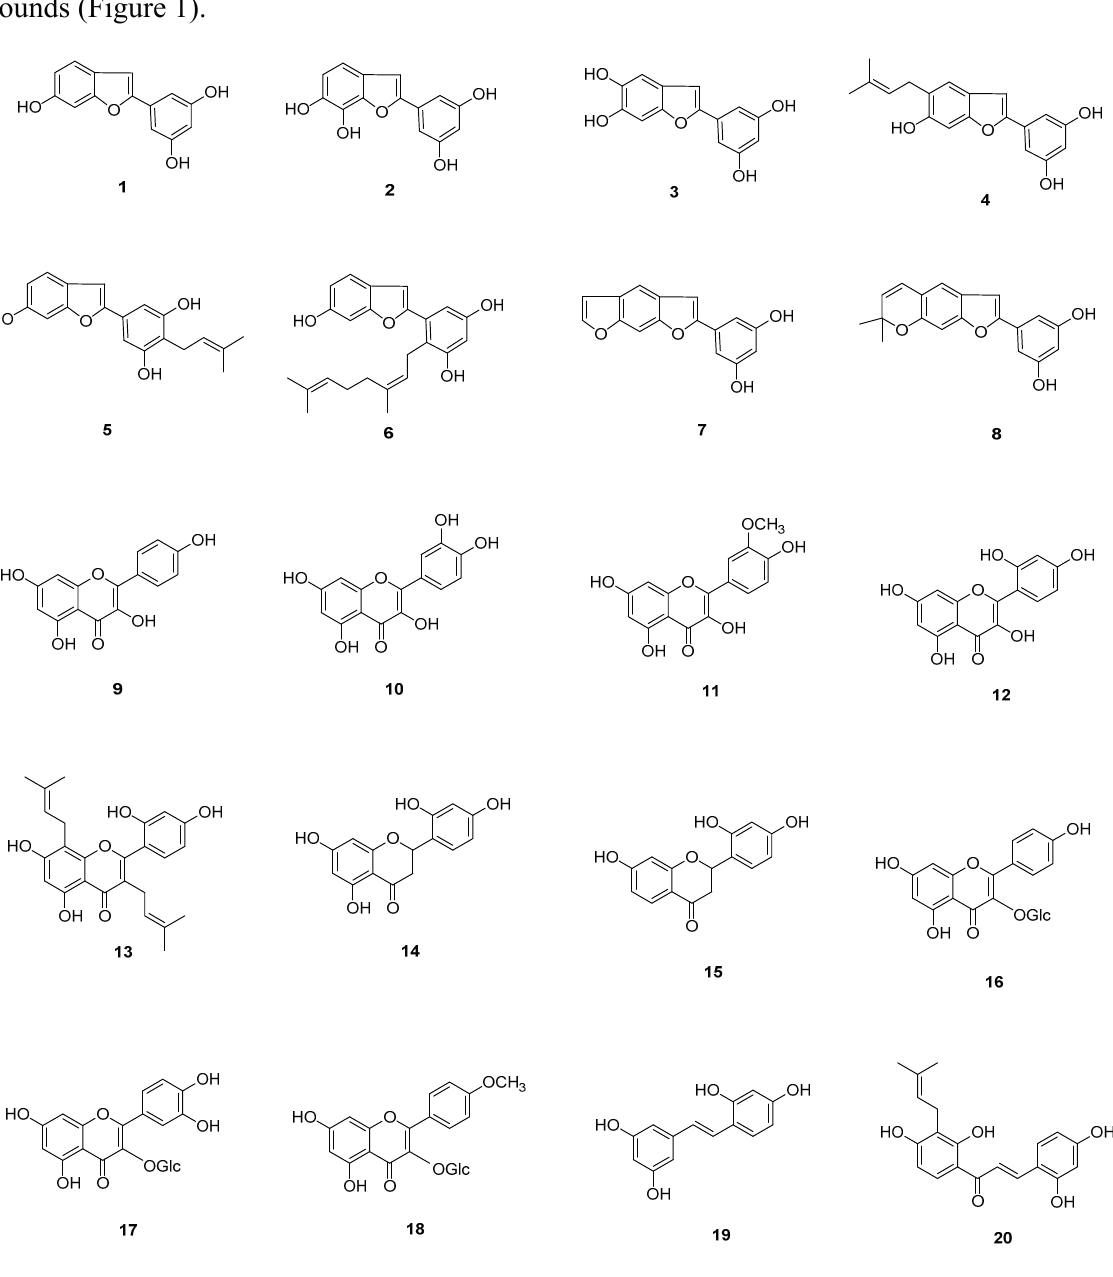
Figure 1. Chemical structures of compounds 1 – 20